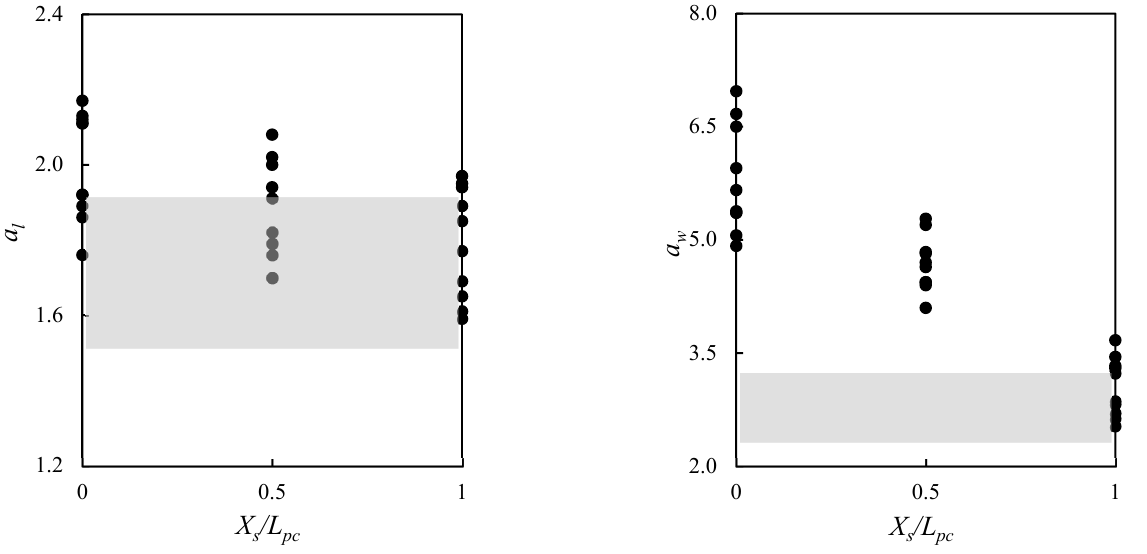
Figure 11. Dimensions of the hole as a function of the sill location. The grey rectangle corresponds to the range of values for the no-sill condition.